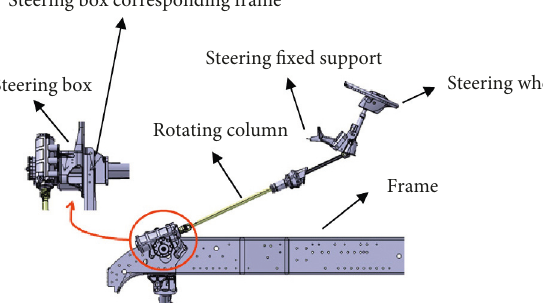
Figure 1: Steering wheel associated vibration path.